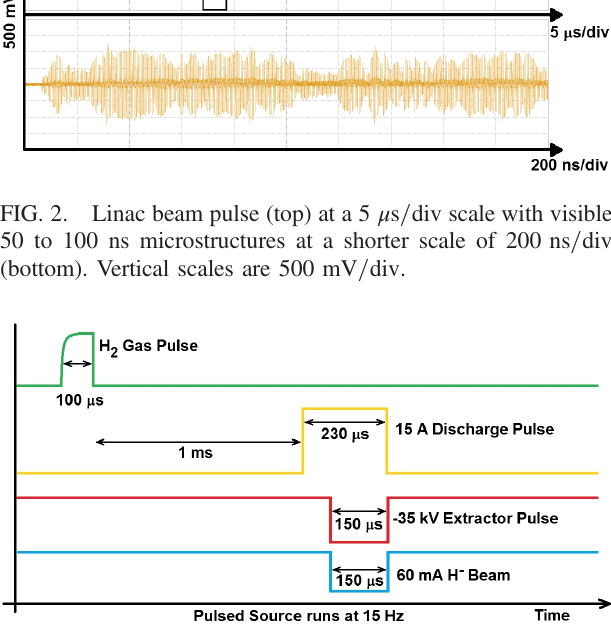
FIG. 3. Schematic of the H − production cycle showing the gas pulse and arc